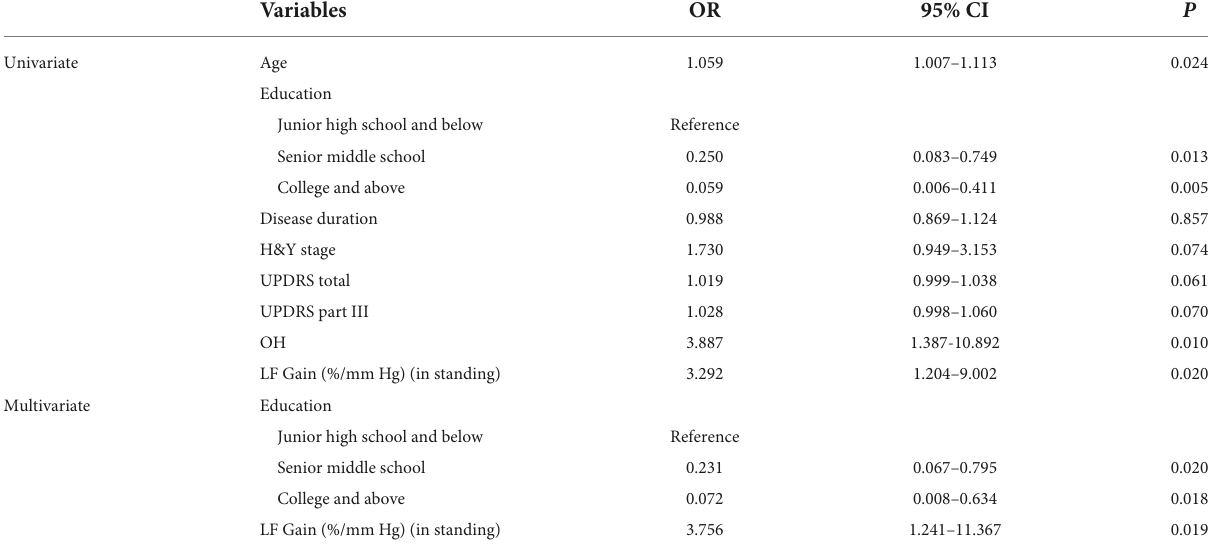
TABLE 6 Univariate and multivariate logistic regression analysis of influencing factors for